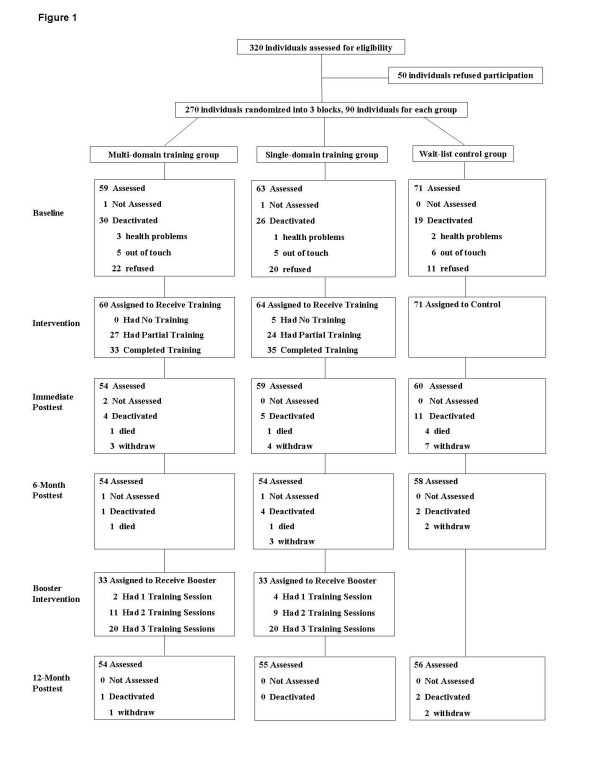
Flow of participants through the trial. 'Refused' due to lack of interest in continuing, repeatedly missed appointments, scheduling conflicts. 'Not Assessed' due to temporary health problems or scheduling conflicts, but willing to keep participating in our research. 'Out of touch' due to home phone or address change, stay out. 'Died' includes cancer, stroke, cardiac sudden death. 'Withdraw' indicates subjects withdrew for reasons including the death of a family member, poor health, lack of interest, had no time, changed contact, stressed. 'Completed Training' means subjects complete 80% of the training sessions (≥ 19 training sessions).